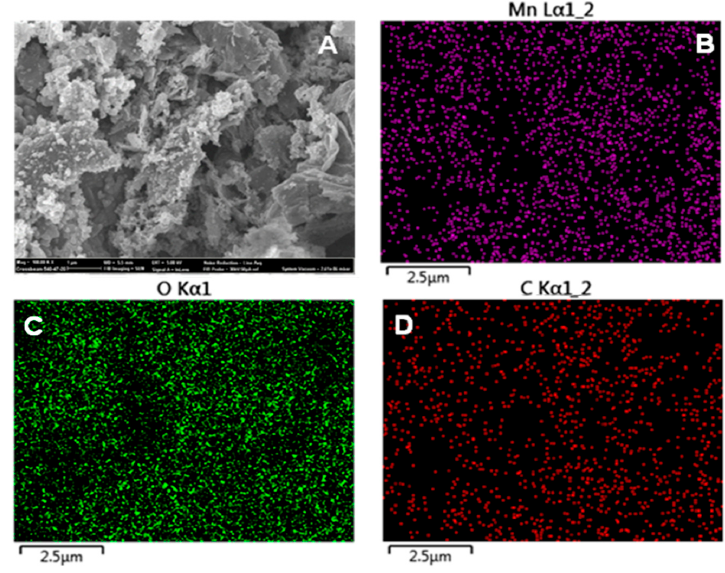
Figure 2. SEM-EDAX mapping of the surface of MnO 2 -GR modified electrode; ( A ) SEM image of MnO 2 -GR nanocomposite and EDAX mapping of the distribution of main elements ( B ) O; ( C ) Mn; ( D ) C.